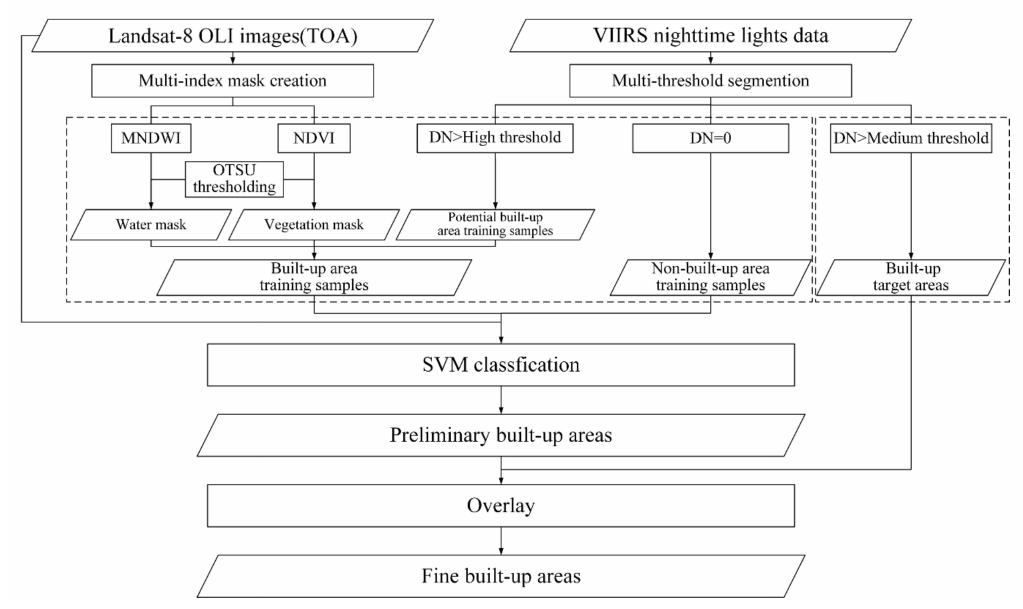
Figure 2. Flowchart of our built-up area extraction